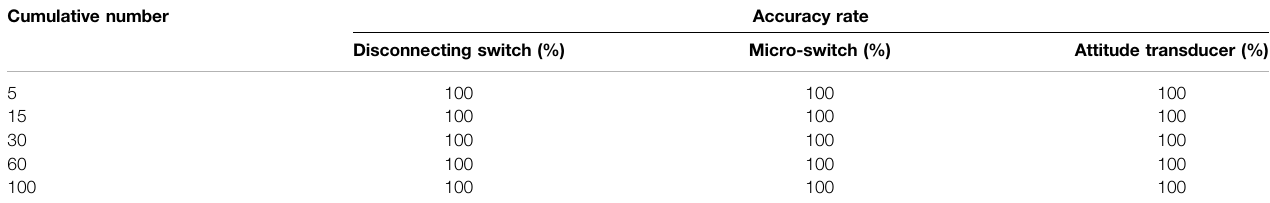
TABLE 2 | Test results of closing-position monitor Cumulative